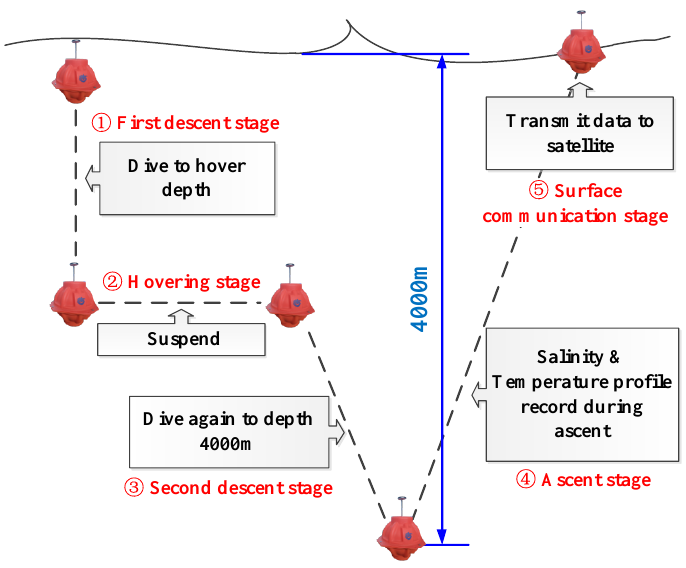
Figure 1. The working process of the deep-sea self-sustaining profile buoy (DSPB).